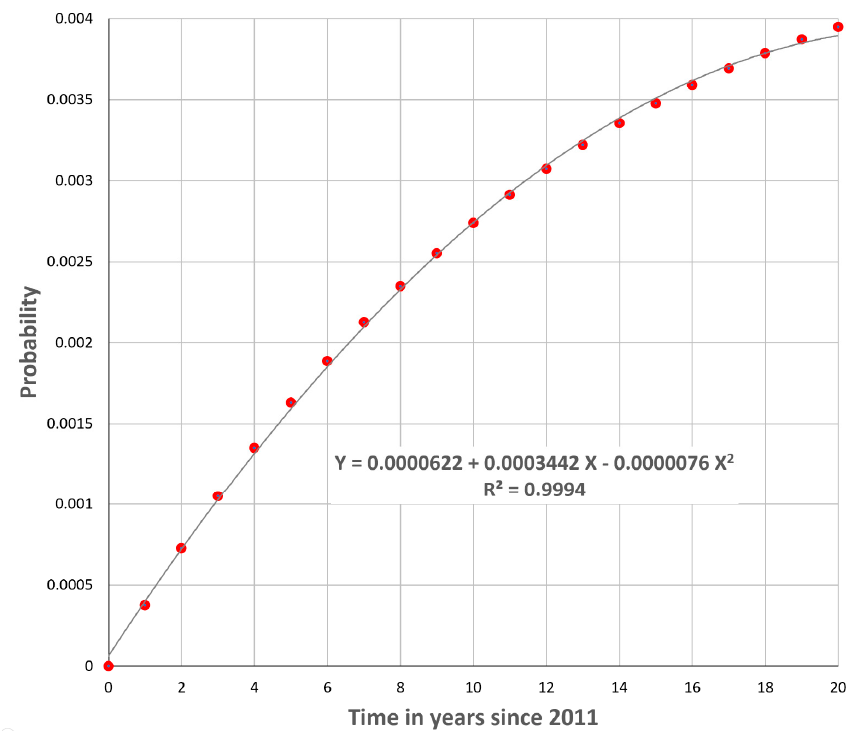
Figure 4. Evolution of the probability of transition from shrub/grassland to barren in Georgia as determined from the TAM program for durations from 1 to 20 years and set to 0 for 0 years (markers) along with the quadratic fit determined by the RBM procedure.